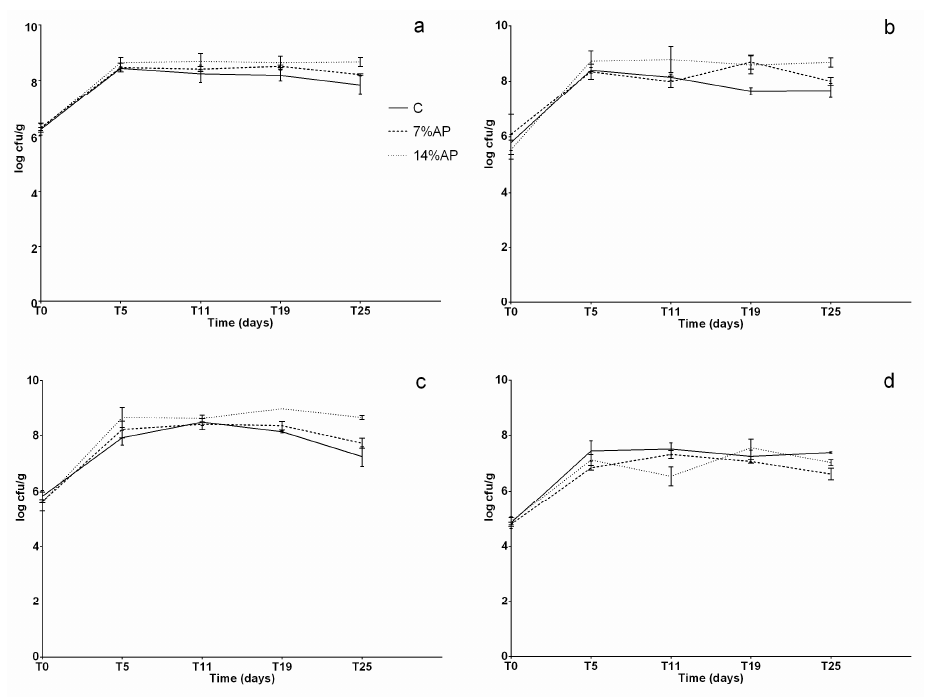
Figure 3. Microbiological analysis of total bacterial count and desirable bacteria during the ripening. ( a ) PCA, plate count agar, total mesophilic aerobic flora; ( b ) MRS, Man, Rogosa and Sharpe agar, Lactobacillus spp.; ( c ) M17 agar, Lactococcus spp.; ( d ) ENT, enterococcus agar, enterococci.